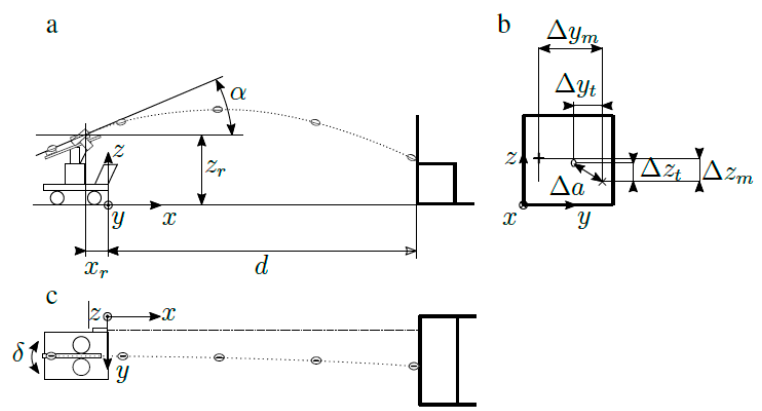
Figure 2. The schematic experiment setup with the passing machine and the target as ( a ): side view, ( b ): front view and ( c ): top view. + marks the reference point on the target that was used to align the machine and the target wall. The dashed and dotted line indicates the laser that was used for alignment. × marks the first impact point of one sample. 0 marks the mean first point of impact for a set of samples with the same 𝛼 and 𝑑 . In ( b ) the target can be observed with ∆𝑎 as the distance between 0 and × . The dotted line indicates the